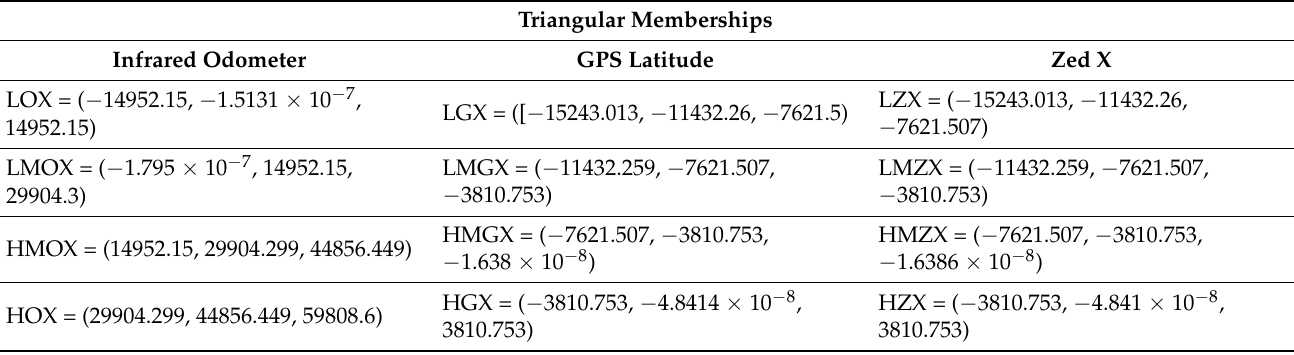
Table 3. Triangular membership functions’ parameters.